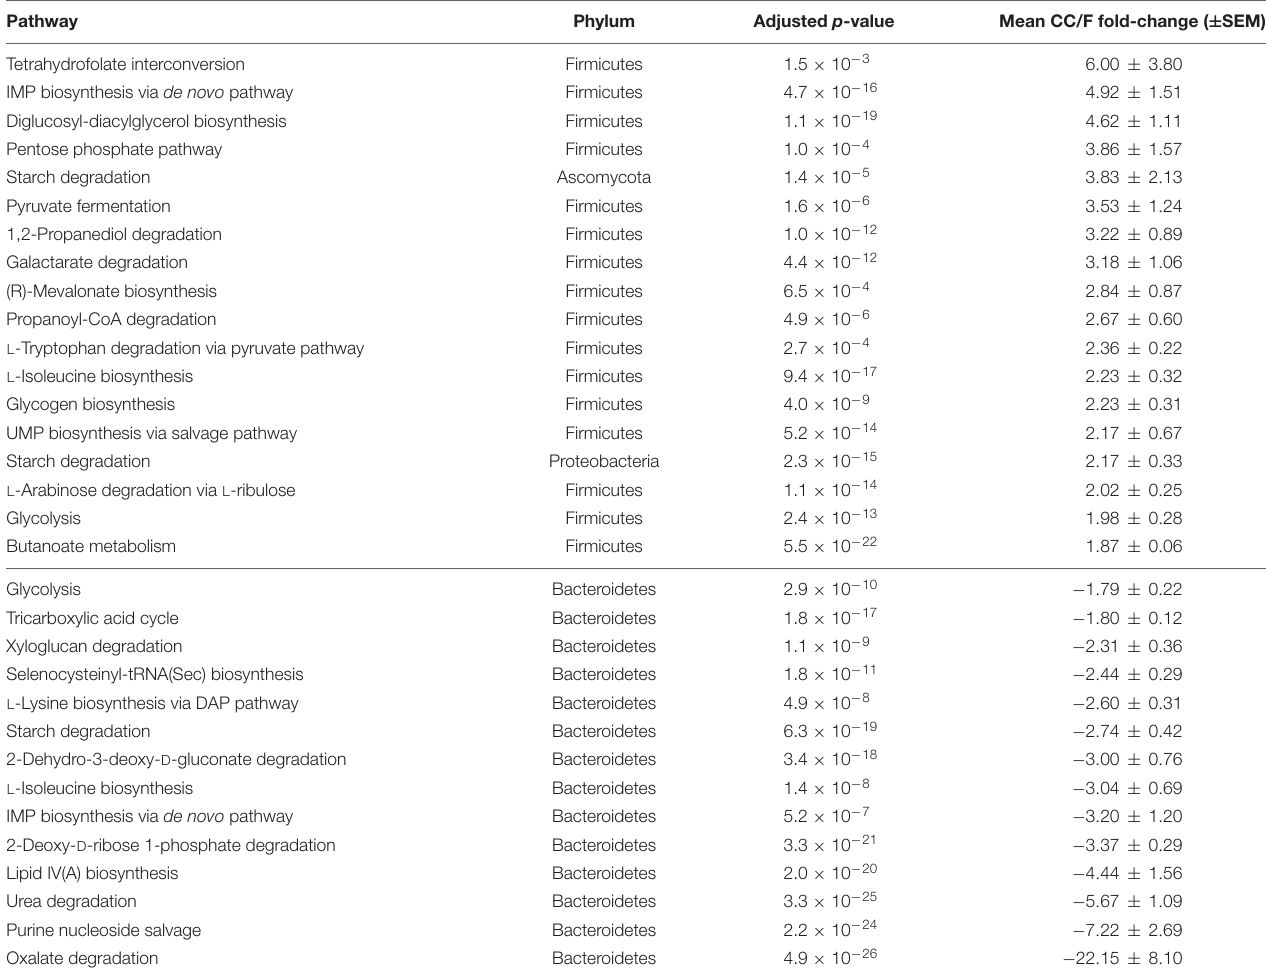
TABLE 4 | Differential pathway-phylum combinations between cecal and fecal metaproteome.